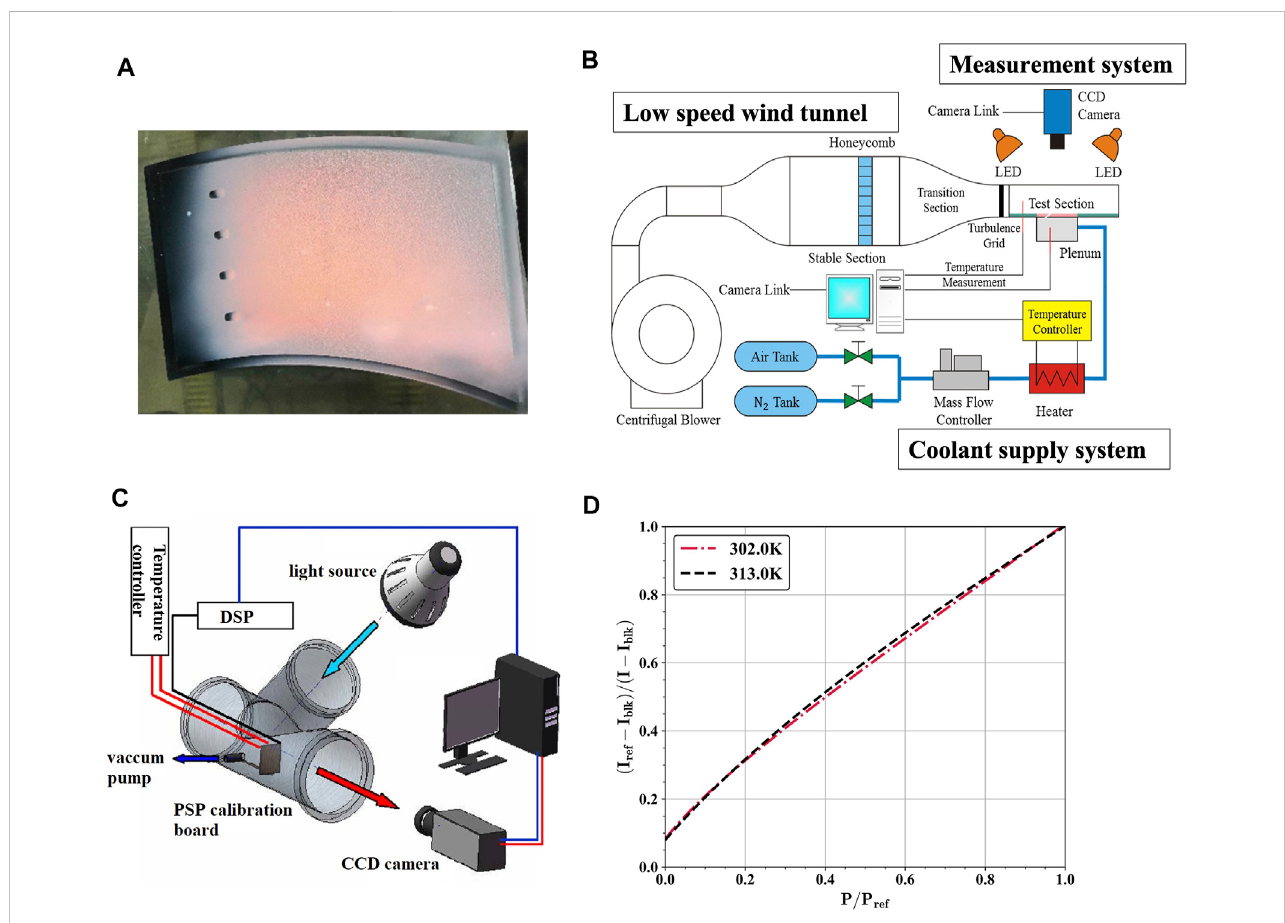
FIGURE 12 Overall experimental con fi guration consists of (A) test section with PSP, (B) low-speed wind tunnel used to perform the fi lm cooling performance, (C) calibration facility for the PSP experiment, and (D) calibration curves for the PSP measurement.